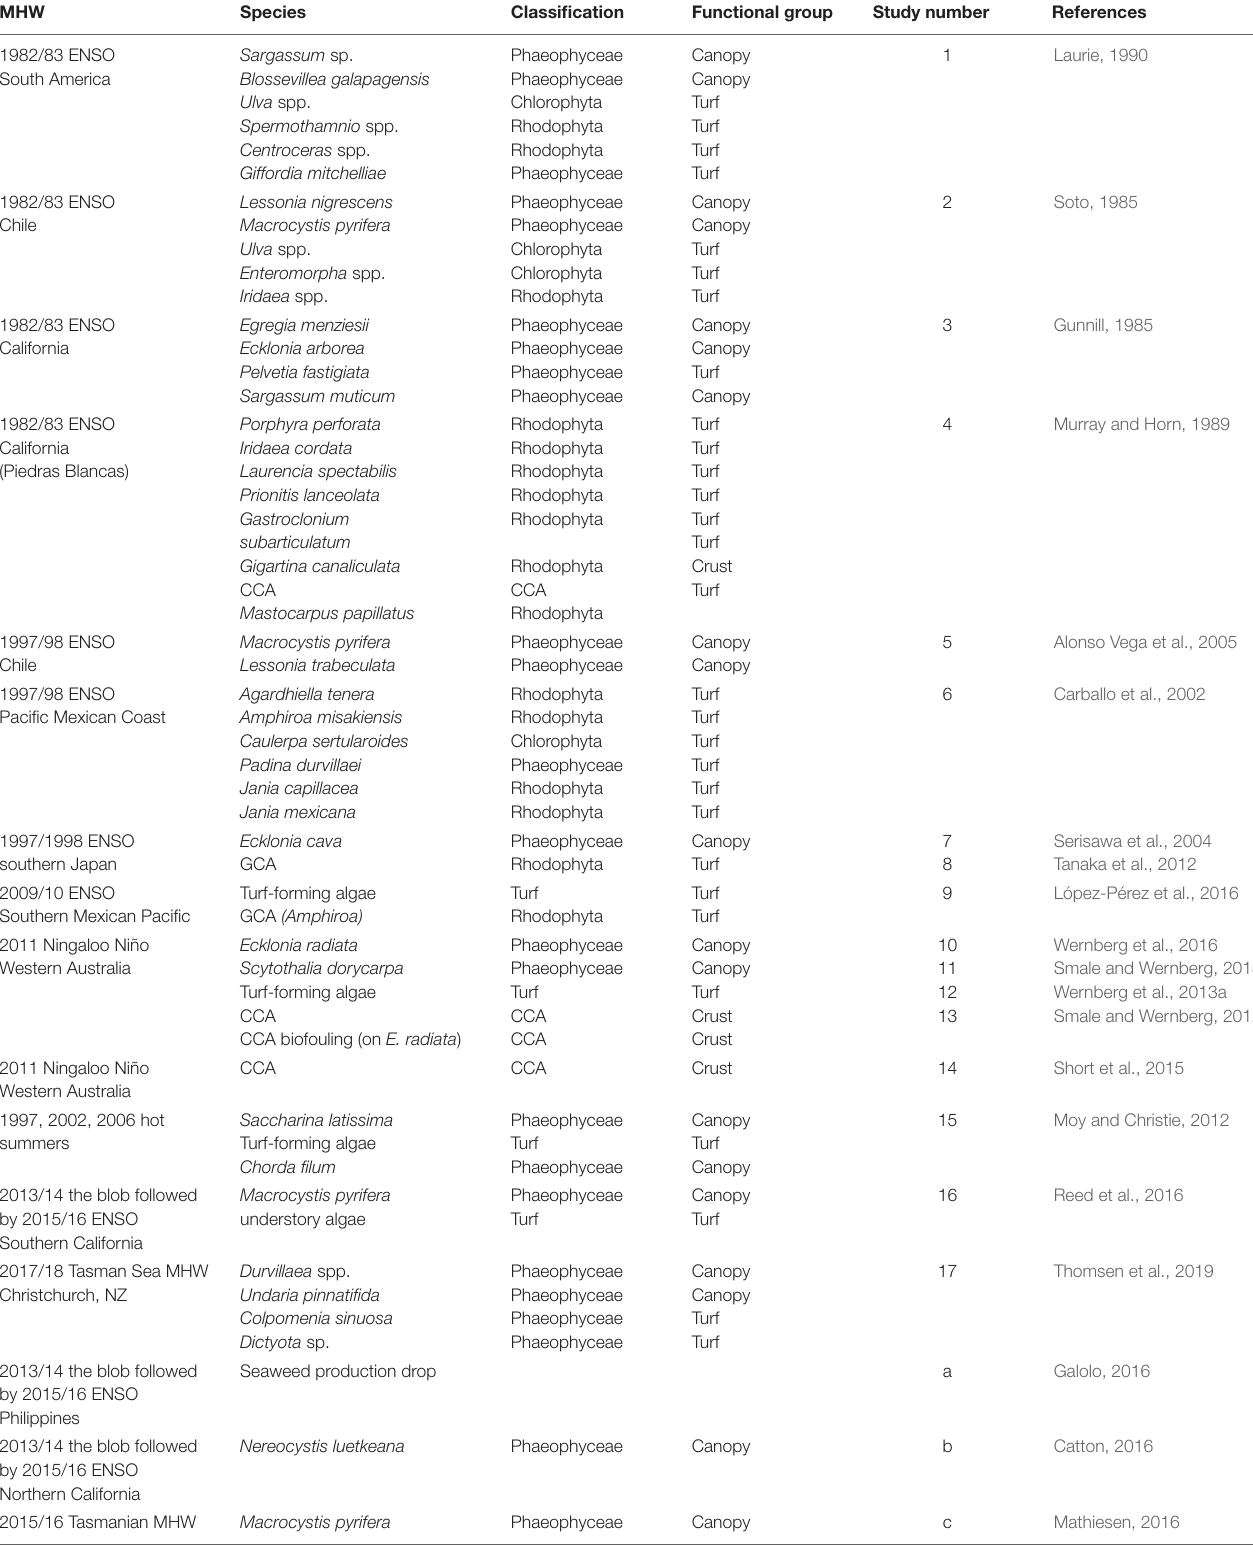
TABLE 1 | Details of studies ( n = 20; 17 journal articles 1 − 17 , three news articles a , b , c ) and species/genera ( n = 58) found with recorded impacts of MHWs on algae.